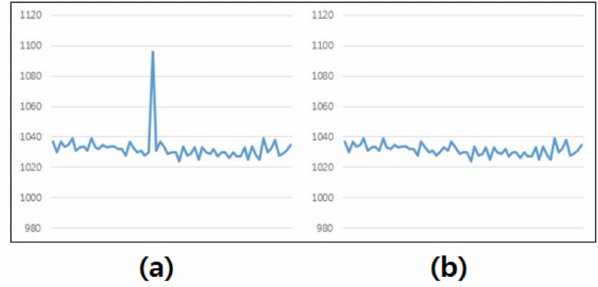
Figure 7. ( a ) Signal noise caused by heartbeat. ( b ) Results after the